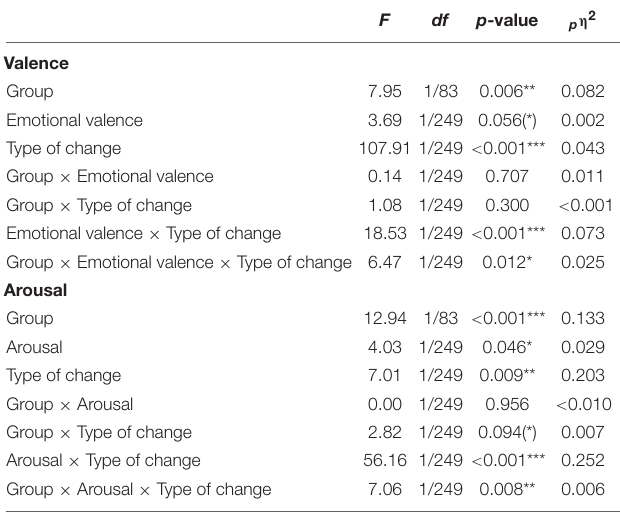
TABLE 2 | Results of the 2 × 2 × 2 rank-aligned ANOVA for whole-body valence and arousal scores.